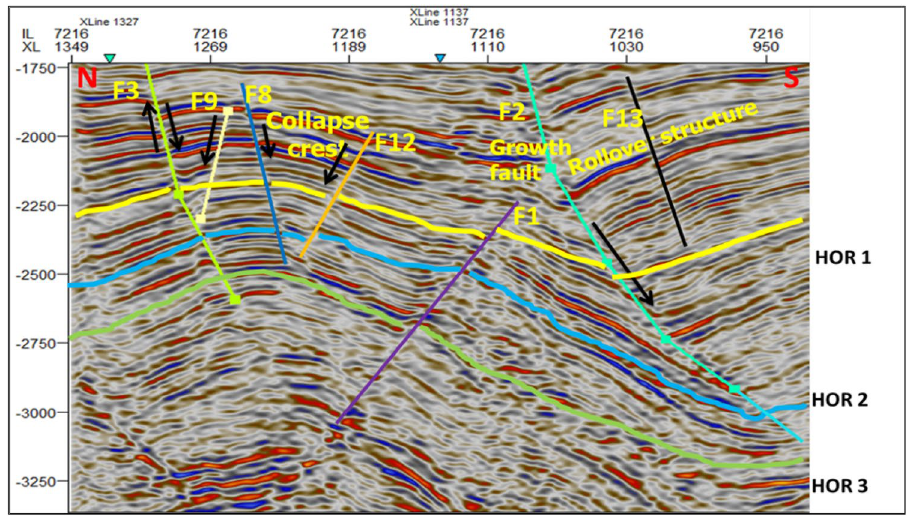
Fig. 2 Typical seismic section (inline 7216) showing structural configuration of ‘DJ’